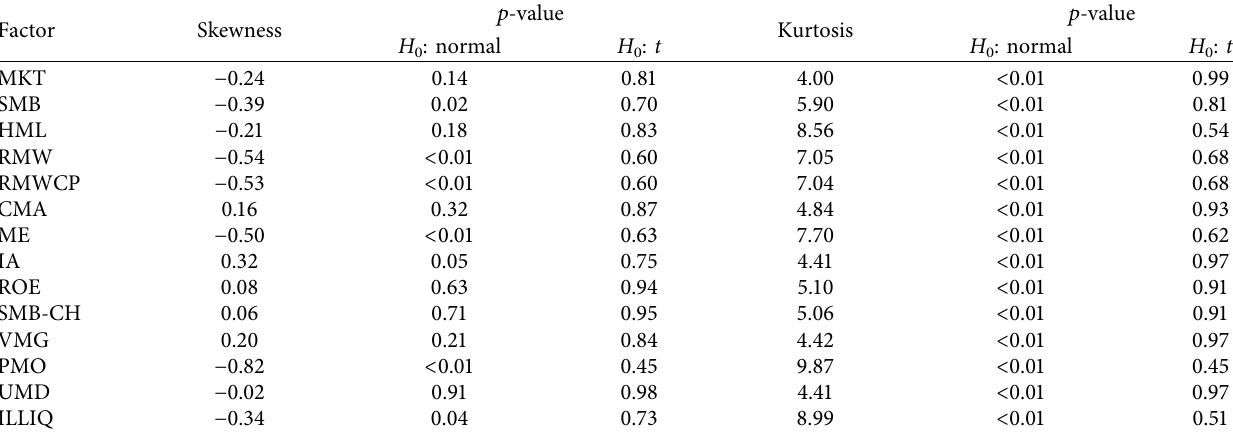
Table 3: Univariate distributional tests.